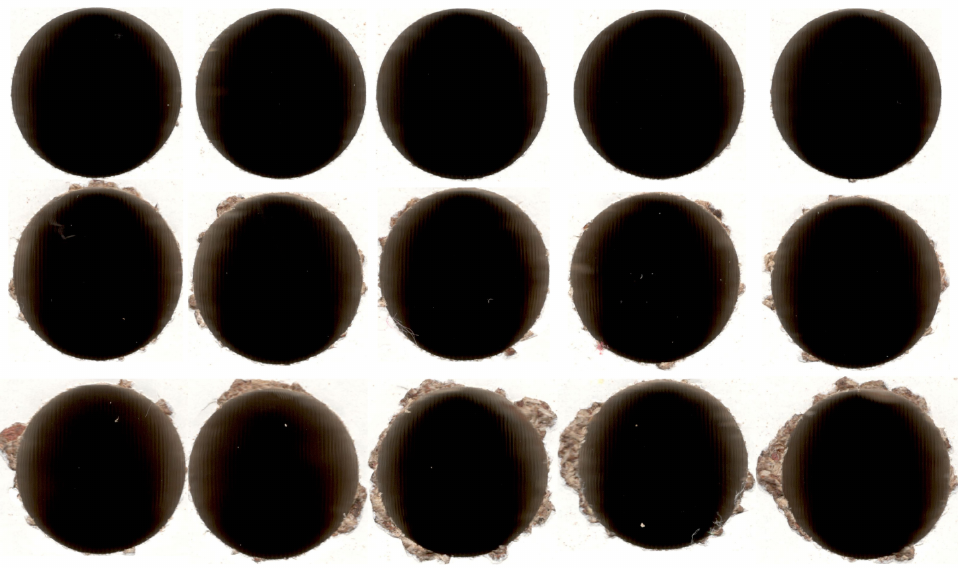
Figure 3. Examples of holes on different profile scans used for research analysis (“Green” on top row, “Yellow” in the middle , and “Red” on bottom